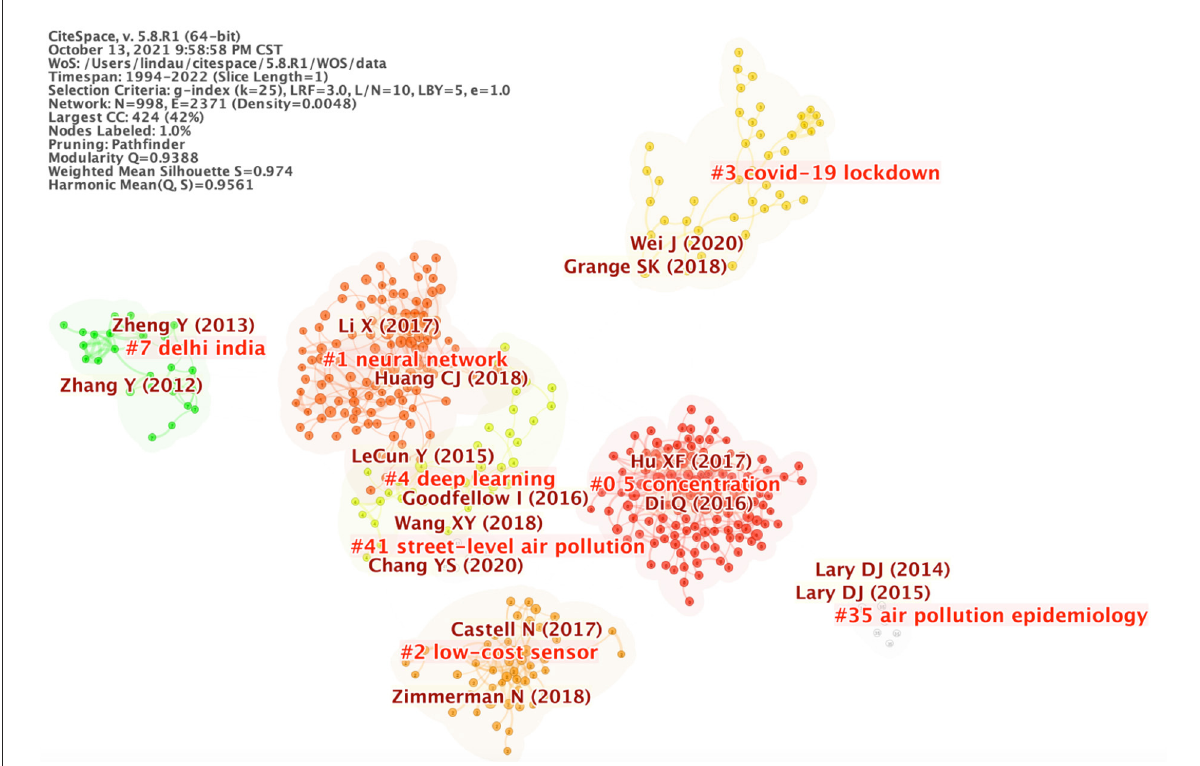
FIGURE4 Map of references clustering. The nodes in the map represent references. The lines between the nodes represent co-occurrence relationships. The larger the node area, the higher the